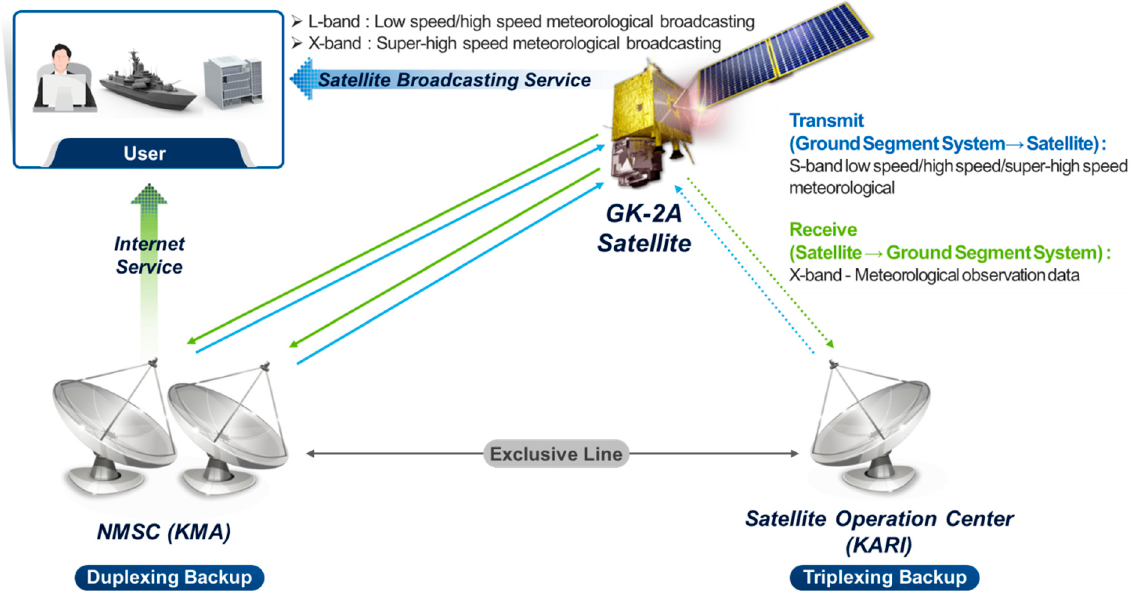
Figure 5. Overview of GK2A ground segment.